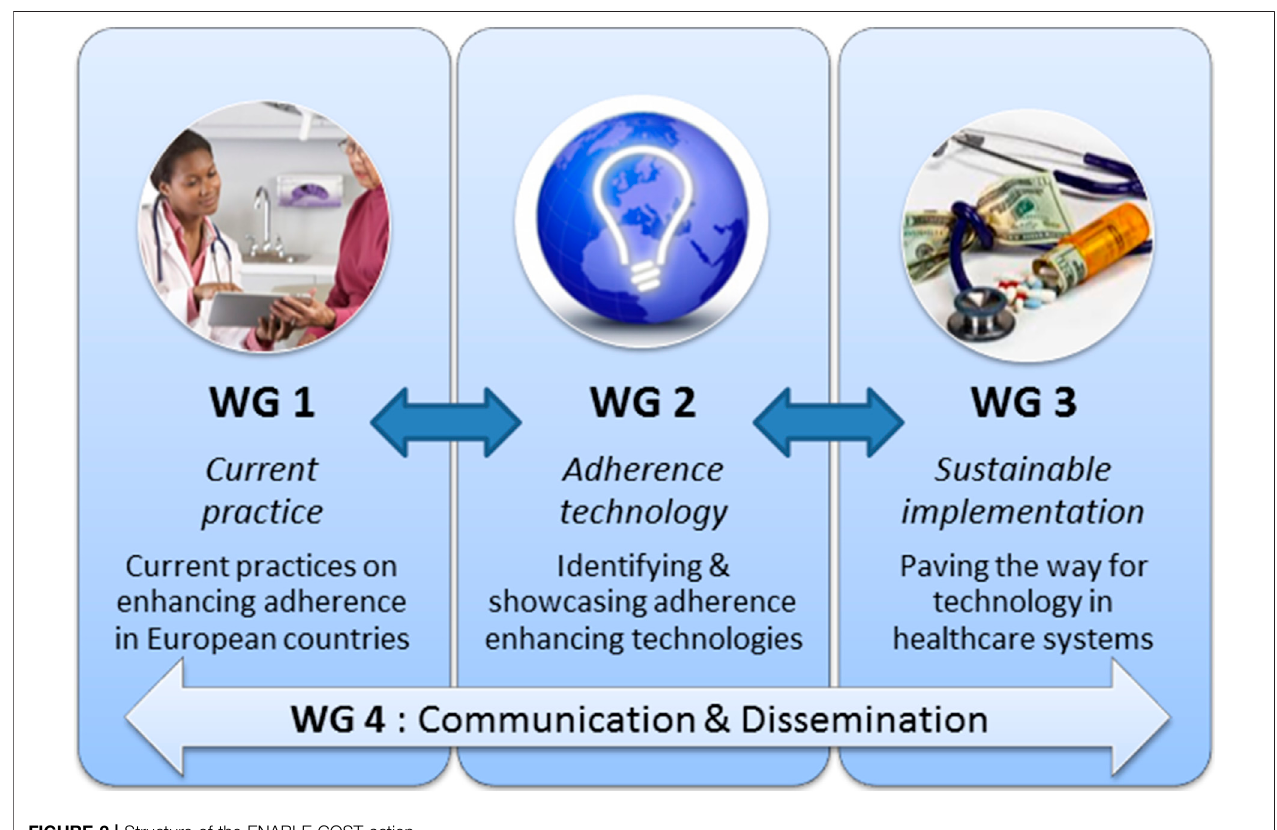
FIGURE 2 | Structure of the ENABLE COST